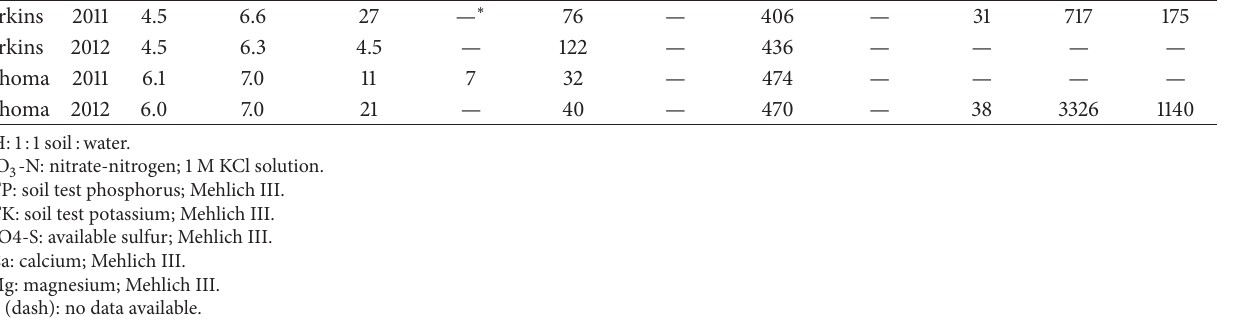
Table 2: Canola stand count as influenced by seed-placed diammonium phosphate (DAP) and nitrogen (N) application method two weeks after emergence at Lahoma and Perkins, OK, in 2011–2013.